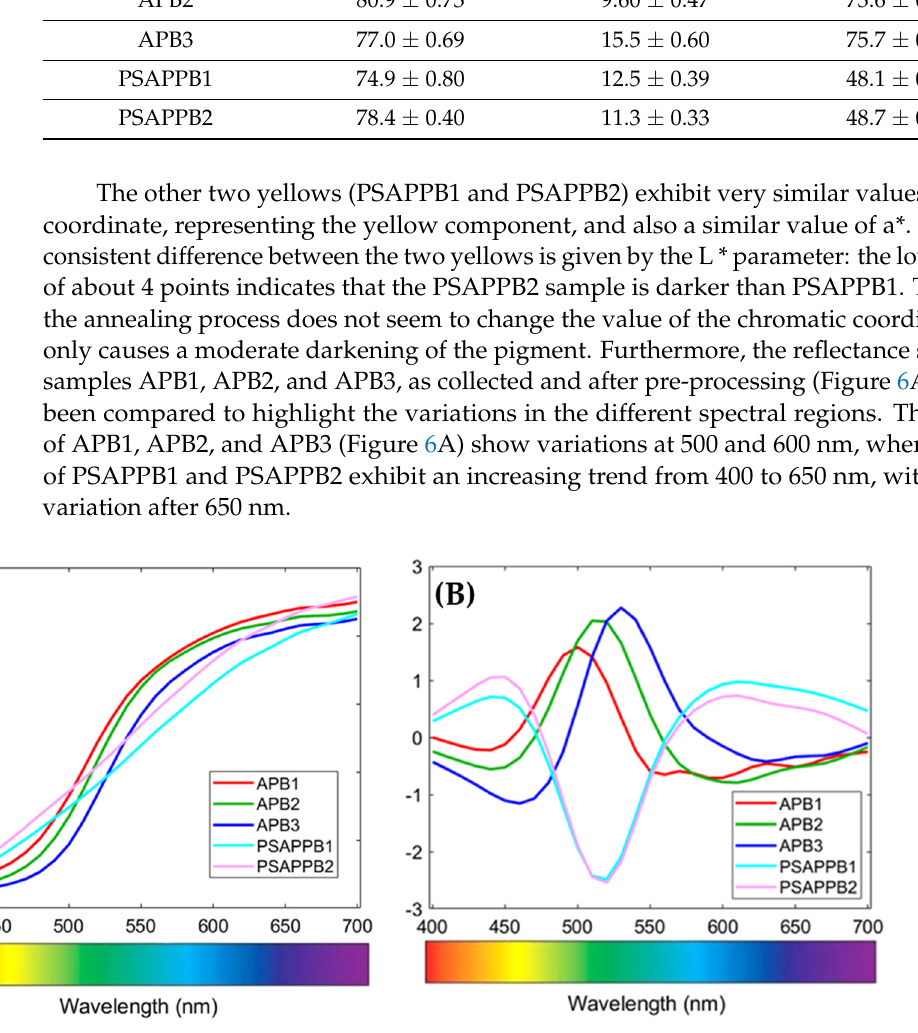
Figure 7. Score plot ( A ) of principal component analysis and loadings ( B ) of the reflectance data of the yellow pigments. The scores plot of PCA (Figure 7A) shows five clusters corresponding to the five yel- low pigments based on lead and antimony. In more detail, it is possible to note that spectra belonging to the ‘APB3’ class can be easily distinguished from pixels of the other classes, being clustered in the fourth quadrant of PC1-PC2. In addition, the PCA score plot shows